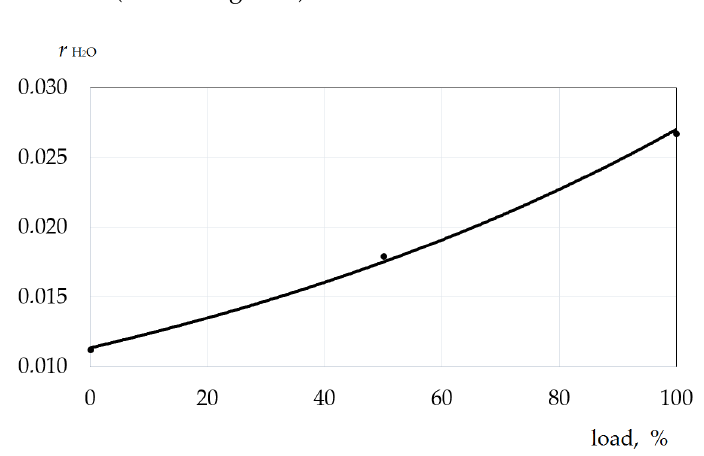
Figure 8. Dependence of mass fraction of water vapor on the load value.